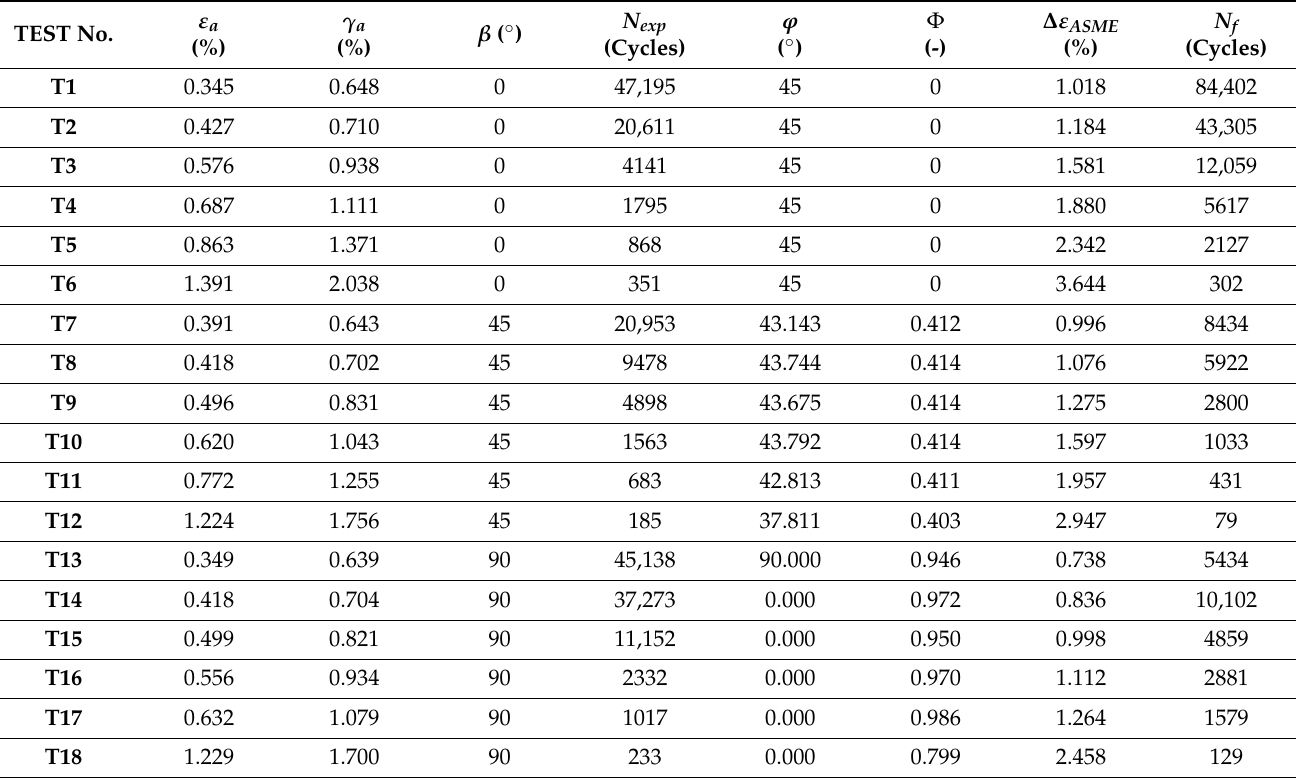
, ( i = 1, . . . ,18) for each strain ASME , i